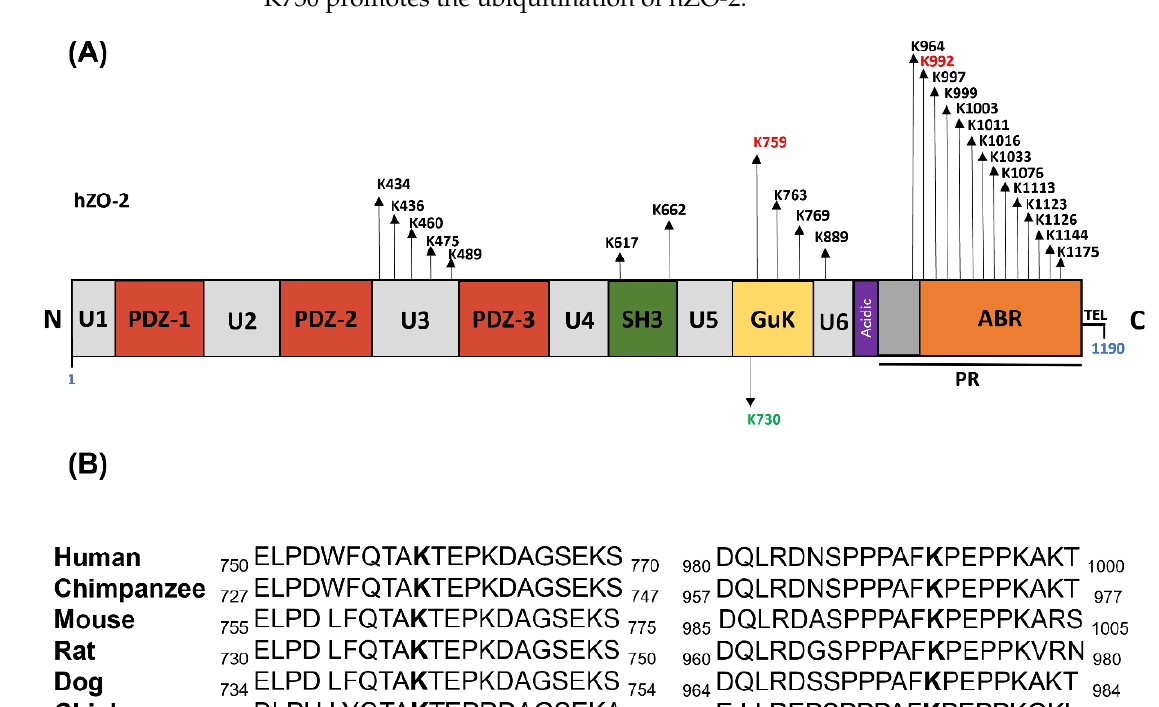
Figure 1. Residues K759 and K992 in hZO-2 are potential targets of ubiquitination. ( A ) Schematic representation of putative ubiquitination sites present in hZO-2. Putative ubiquitination sites are indicated above the scheme of hZO-2, and residues K759 and K992 are shown in red, whereas the SUMOylation site K730 is shown below in green. The scheme of hZO-2 illustrates the distribution of PDZ, SH3, Guk (guanylate kinase), and acidic domains; the unique (U) regions 1 to 6; the proline-rich (PR) region; the actin-binding region (ABR); and the PDZ-binding motif, TEL. ( B ) Residues K759 and K992 are conserved in different species. K759 and K992 residues are marked in bold in the alignment of ZO-2 amino acid sequences from different species.